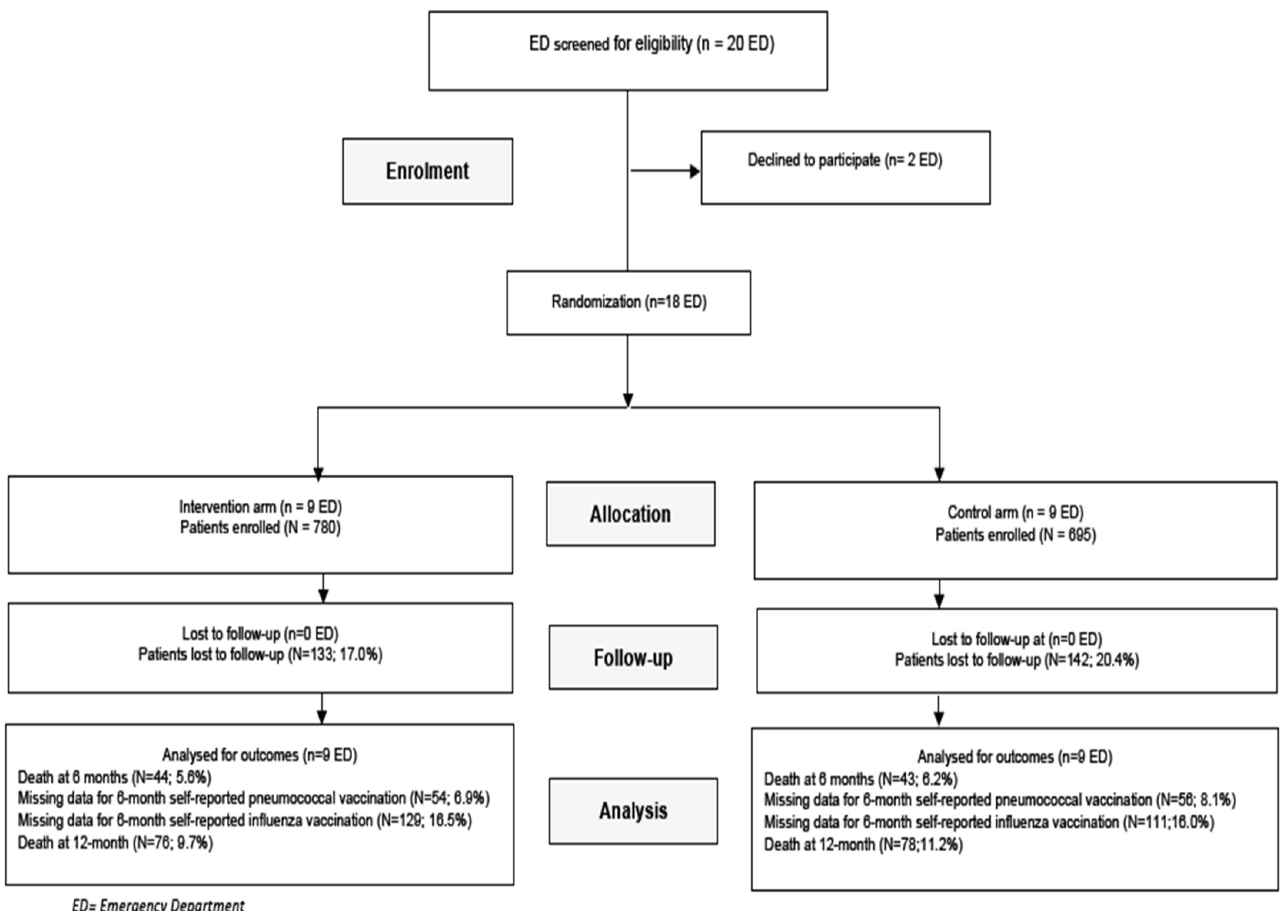
Figure 1. Consort flow diagram, IMPROVED trial . ED = emergency department